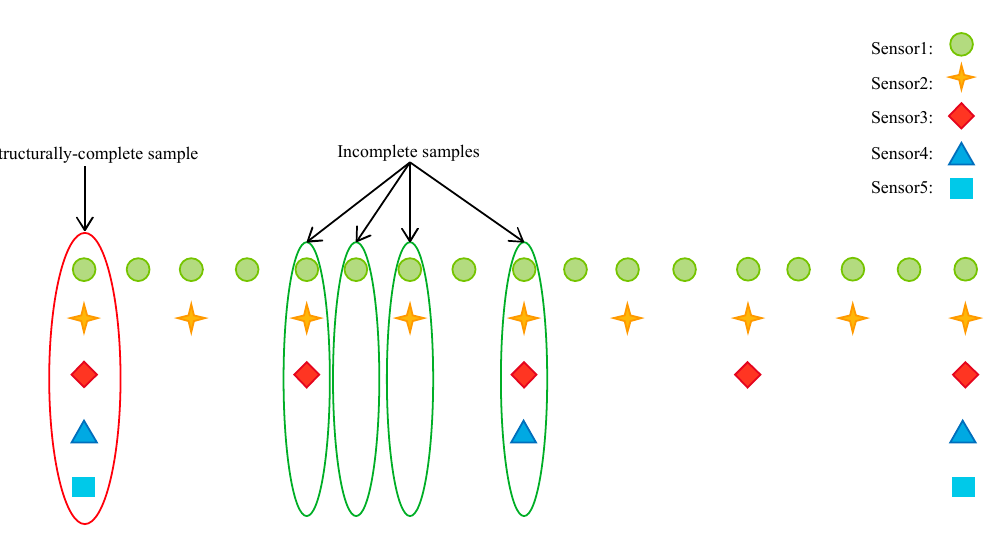
Figure 2. The fault diagnosis framework with missing data.